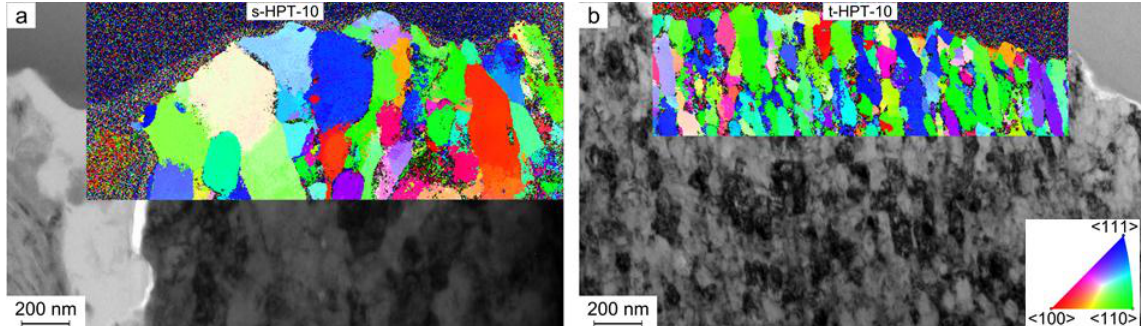
Figure 13. Cross section of the crack initiation ( a ) non-metallic inclusion for s-HPT-10 and ( b ) crack path near crack initiation from the surface for t-HPT-10. The overlays are orientation maps in projection direction normal to the paper plane with the reliability in black. The color code of the orientation maps is given in (Figure